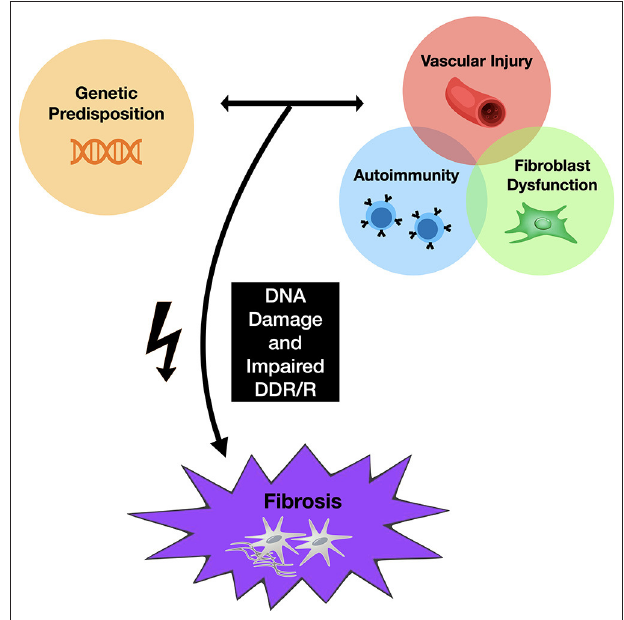
FIGURE 1 | Proposed mechanism of skin fibrosis associated with chemotherapy. Genetic predisposition to SSc, along with changes in both the innate and adaptive immune responses, promote fibroblast dysfunction and vascular damage, leading to fibrosis. Abnormal DNA damage response repair pathways have also been identified in patients with SSc, suggesting that cells from patients with SSc may be more susceptible to DNA damaging agents. Chemotherapeutic agents may provide the additional cellular “hit” that promotes abnormal DNA damage responses and subsequent inflammatory